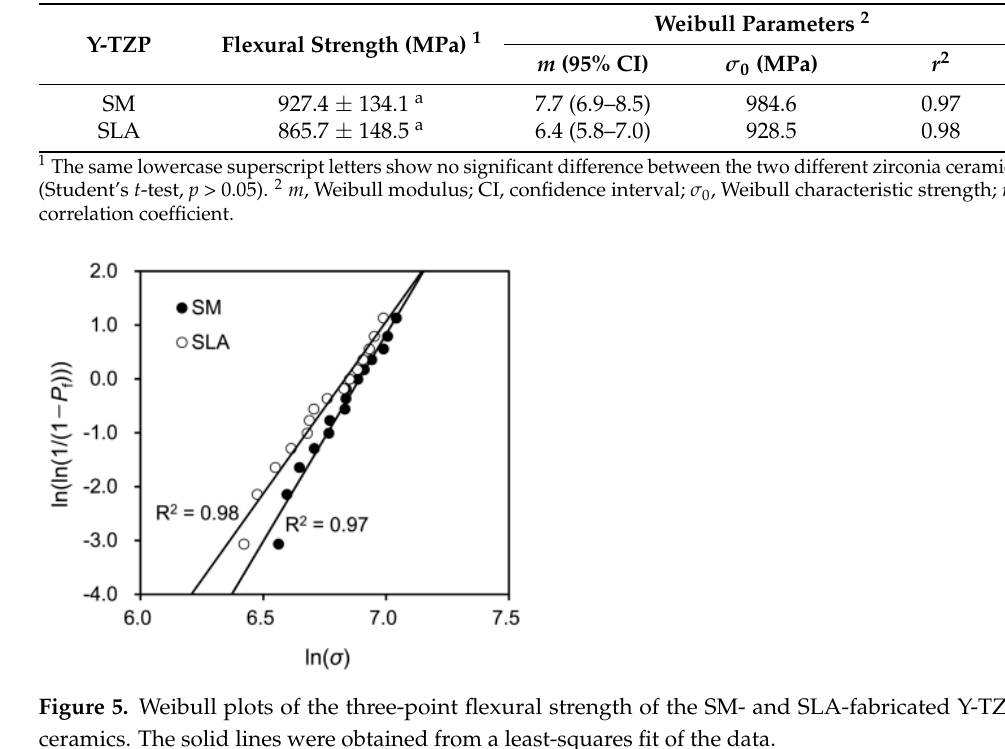
Table 2. Three-point flexural strength values (means ± standard deviations) of the SM- and SLA- fabricated Y-TZP ceramics and their respective Weibull parameters.